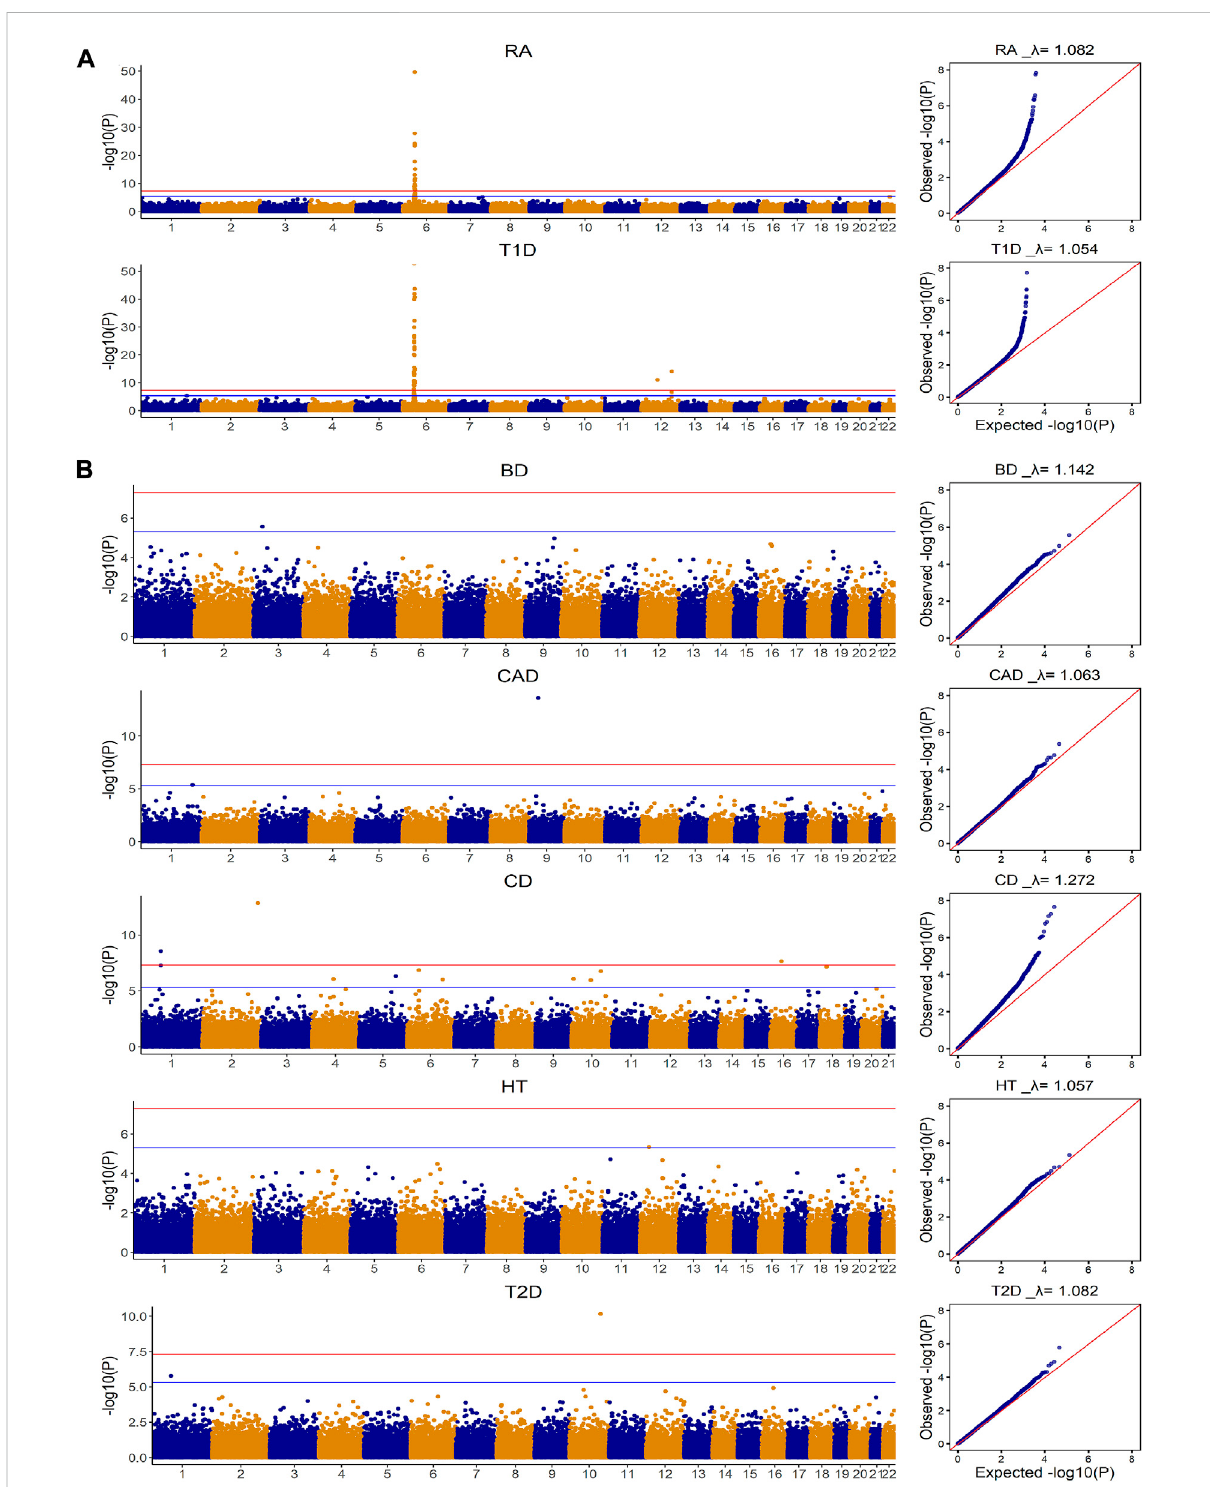
FIGURE 1 Manhattan and Quantile-Quantile plots for seven diseases in WTCCC based on additive model for Genome-wide association analysis. CD: Crohn ’ s disease; RA: Rheumatoid arthritis; T1D: Type 1 diabetes; BD: Bipolar disease; CAD: Coronary artery disease; HT: Hypertension; T2D: Type 2 diabetes. The λ closer to 1 indicates appropriate control of population structure (A) This group included T1D and RA, where Manhattan plots suggested dense and spiked signals at the genome-wide signi fi cancelevel (i.e., p < 5 × 10 – 8 ) (B) This group included BD, CAD, CD, HT and T2D, where their Manhattan plots indicated only few SNPs achieved signi fi cance at a suggestive genome-wide signi fi cance level (i.e., p < 5 × 10 – 6